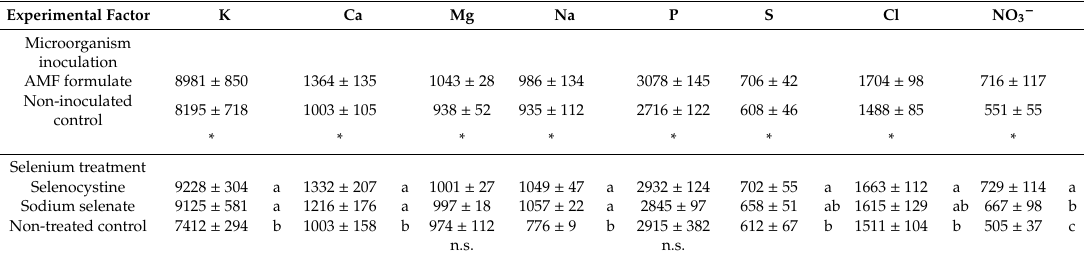
Table 3. Shallot bulb macro-elemental composition as a ff ected by microorganism inoculation and selenium treatments.